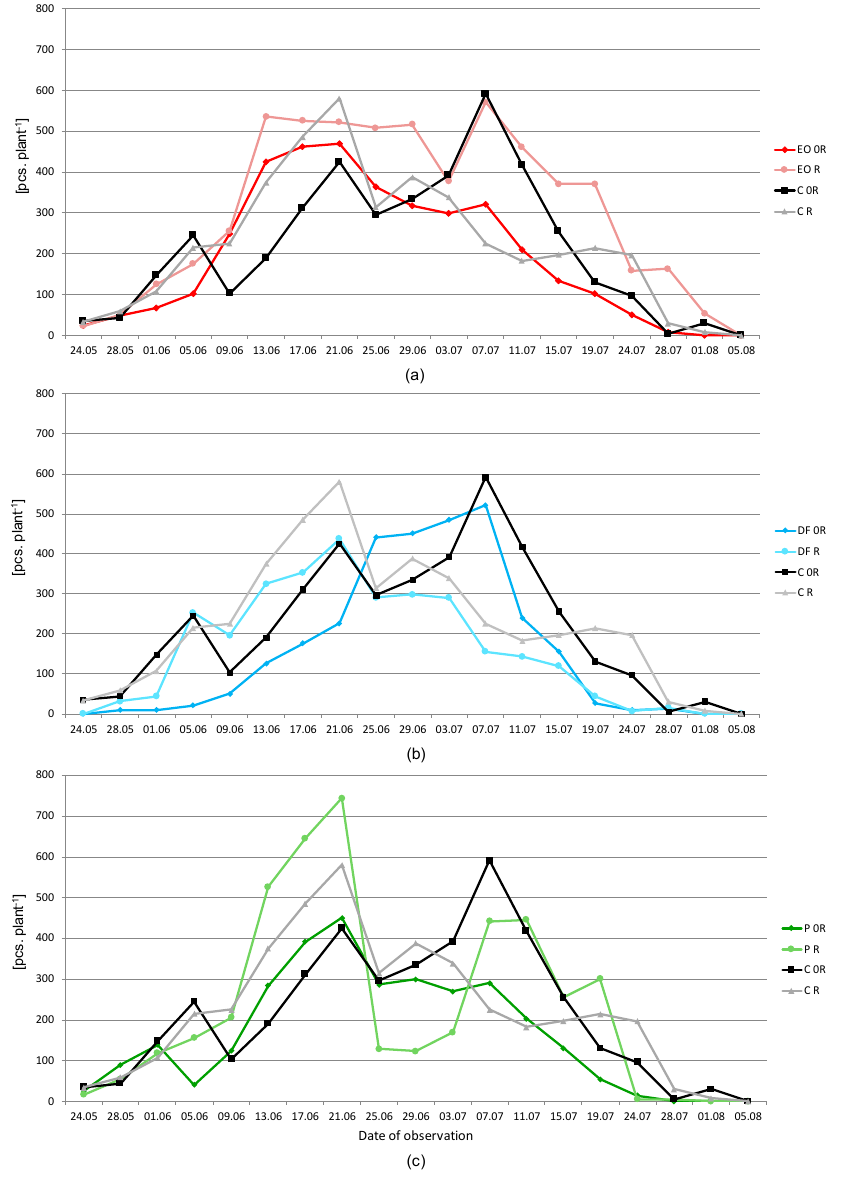
Figure 1. The dynamics of Aphis fabae Scop occurrence on broad bean plants after three years from the soil contamination with petroleum-derived substances and the use of ZB-01 biopreparation (pcs. plant − 1 ); plants exposed to engine oil ( a ), diesel fuel ( b ) and petrol ( c ). EO—soil contaminated with engine oil, DF—soil contaminated with diesel fuel, P—soil contaminated with petrol, C—control soil, 0R—without bioremediation, R—with bioremediation.